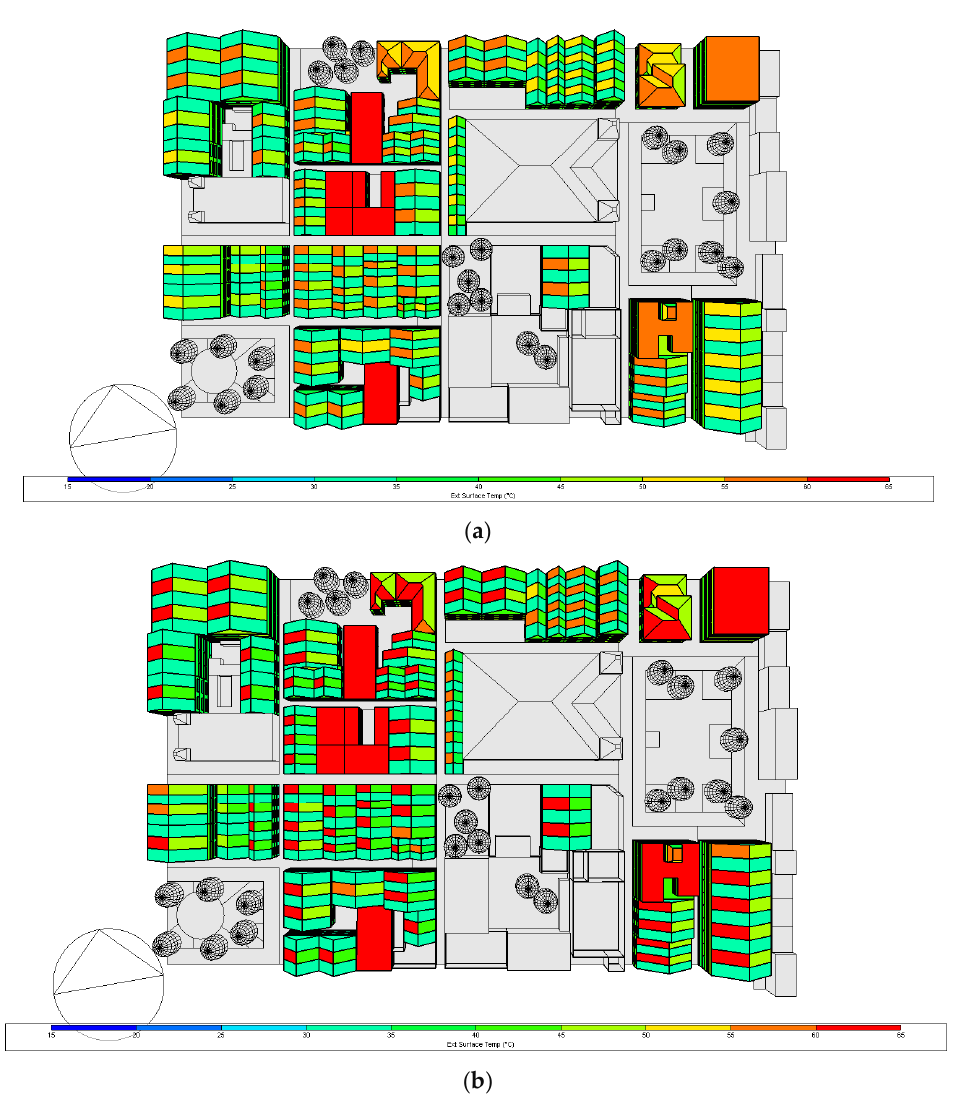
Figure 11. External surface temperature for the base case: ( a ) 17 March and ( b ) 20 October at 15 h. Own elaboration.